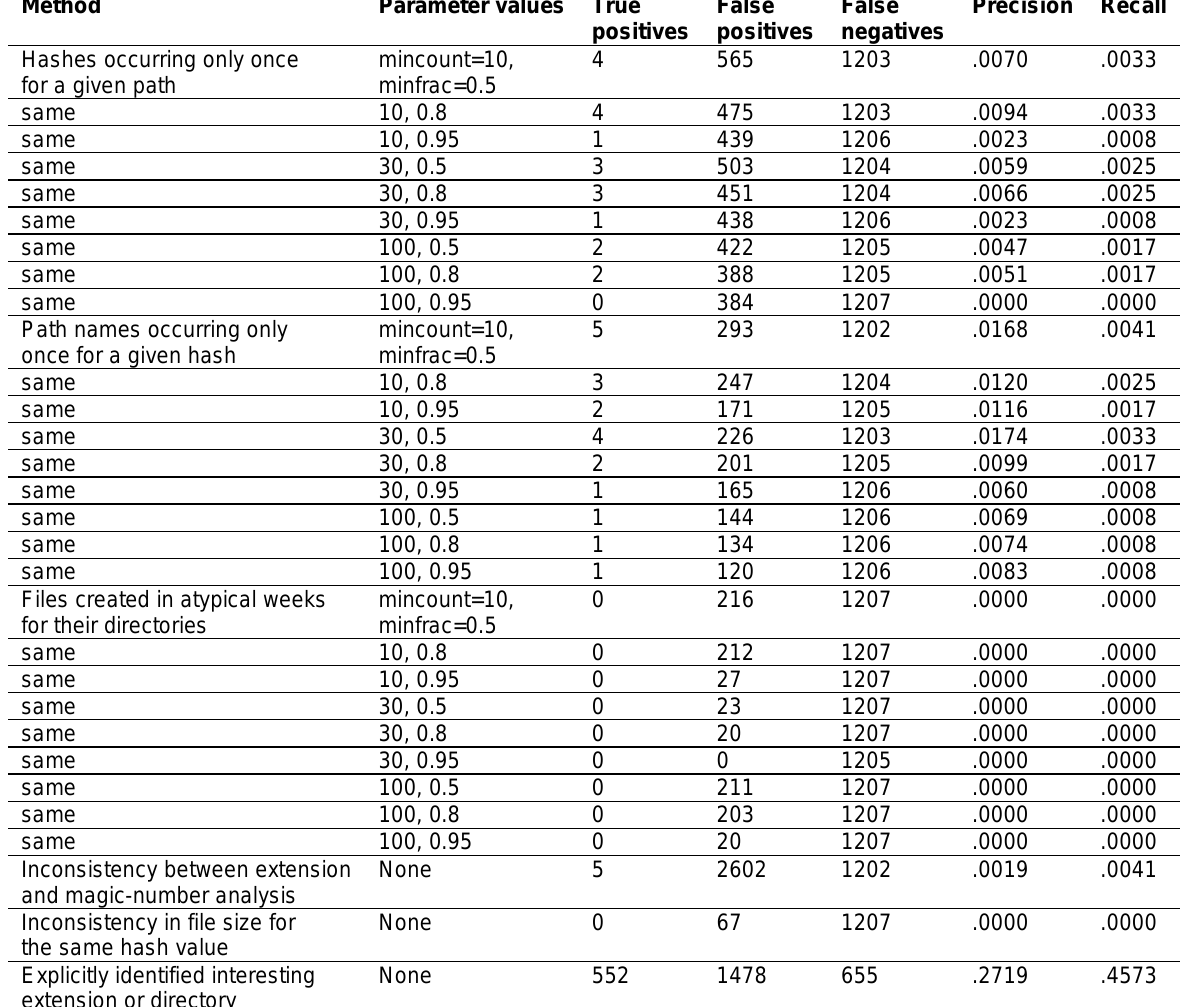
Table 7. Effects on parameter variation on performance of different methods for identifying interesting files.